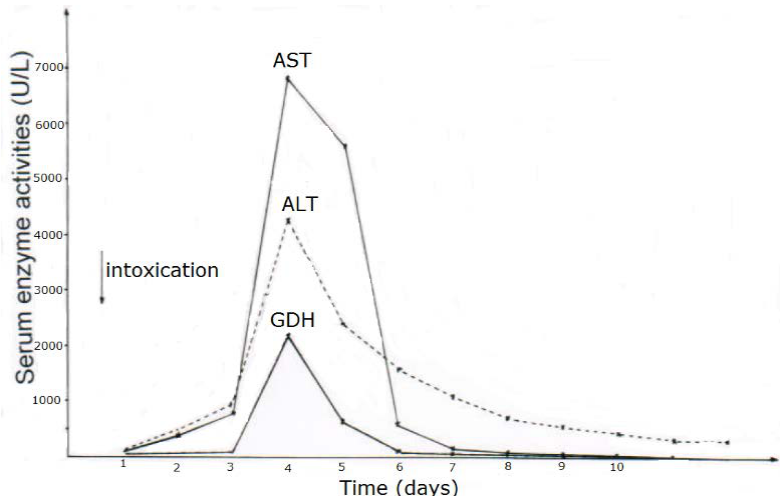
Figure 6. Patient 5 with ingestion of 100 mL CCl 4 and serum activities of AST, ALT, and GDH during CO 2 -induced hyperventilation therapy for 10 days. Abbreviations: ALT, Alanine aminotransferase; AST, Aspartate aminotransferase; GDH, Glutamate dehydrogenase.